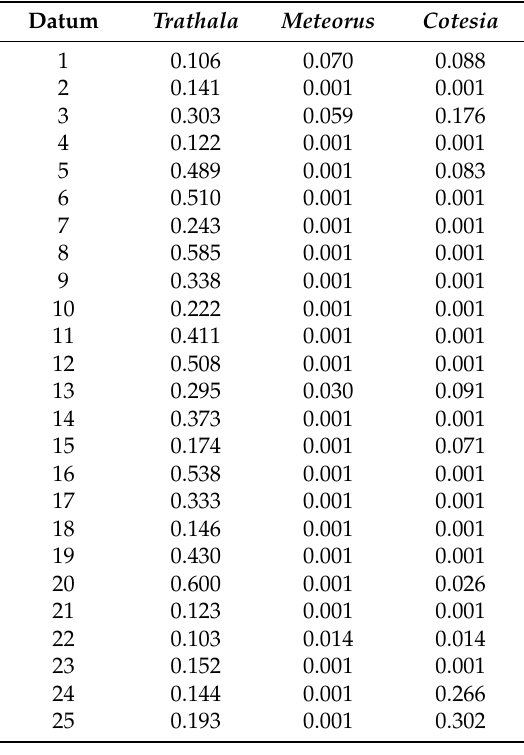
Table 4. Apparent mortality data used in simulations for Question 3. (Data from [35]).